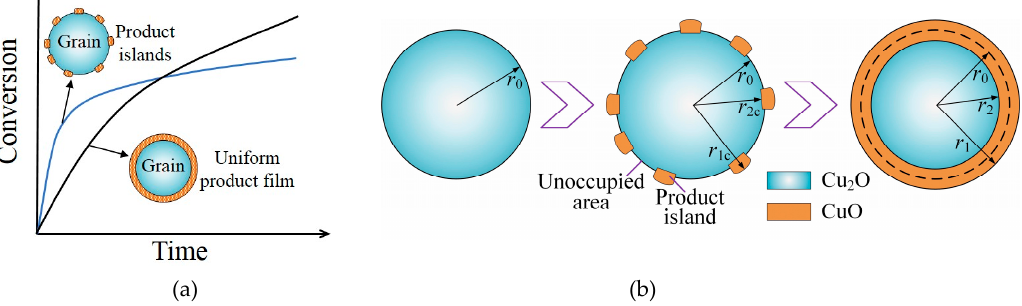
Figure 2. ( a ) Comparison of the product-islands-based model and traditional grain model; ( b ) Schematic diagram of the solid product morphology on grain surface during the oxidation reaction. It is considered that O 2 contacts with two different kinds of grain surfaces in the model, that is, Cu 2 O surface (solid reactant surface) and CuO surface (solid product surface) [22]. In the case of O 2 contacting Cu 2 O surface, the reaction described in Section 2.1 will take place directly on this surface, considered as a critical value of r 2c and r 1c , as shown in Figure 2b, where r 2c is the critical grain radius of Cu 2 O/CuO interface and r 1c is the critical grain radius of CuO/O 2 interface. The critical solid reactant layer thickness is described as h c = r 0 − r 2c , where r 0 is the initial grain radius. A key parameter